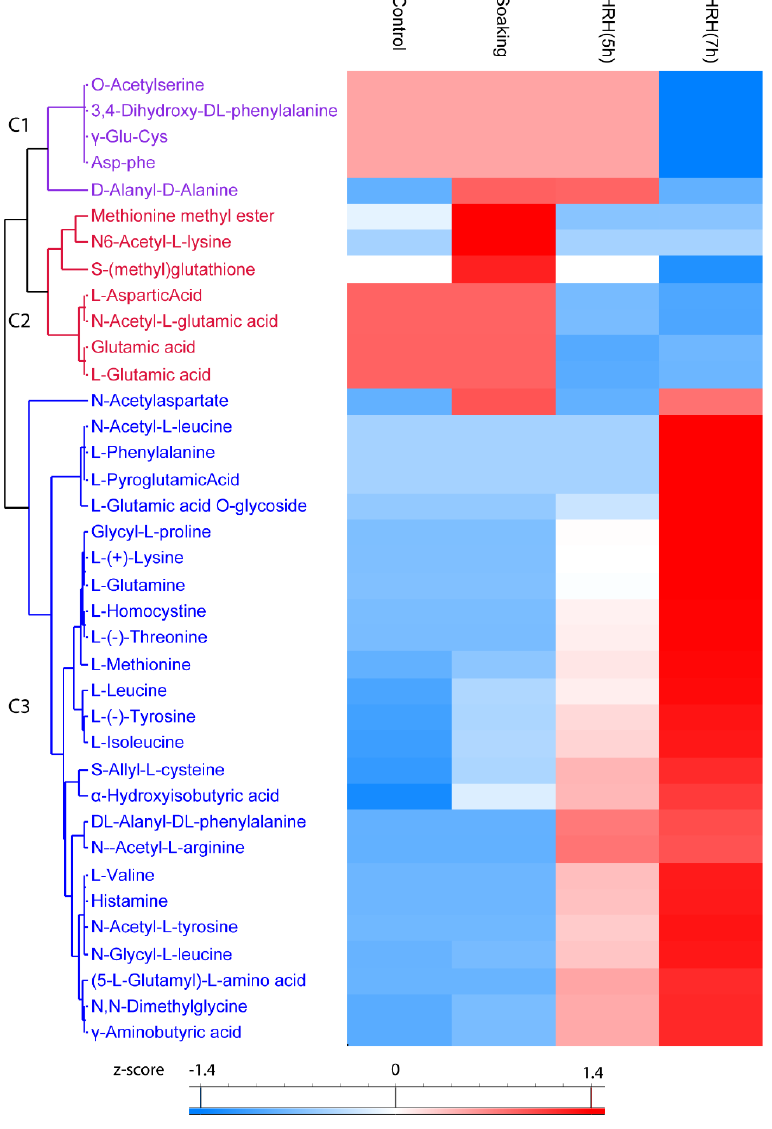
Figure 3. Hierarchical cluster analysis based on peak area of amino acids and its derivatives. C1–C3: Cluster 1 – 3.